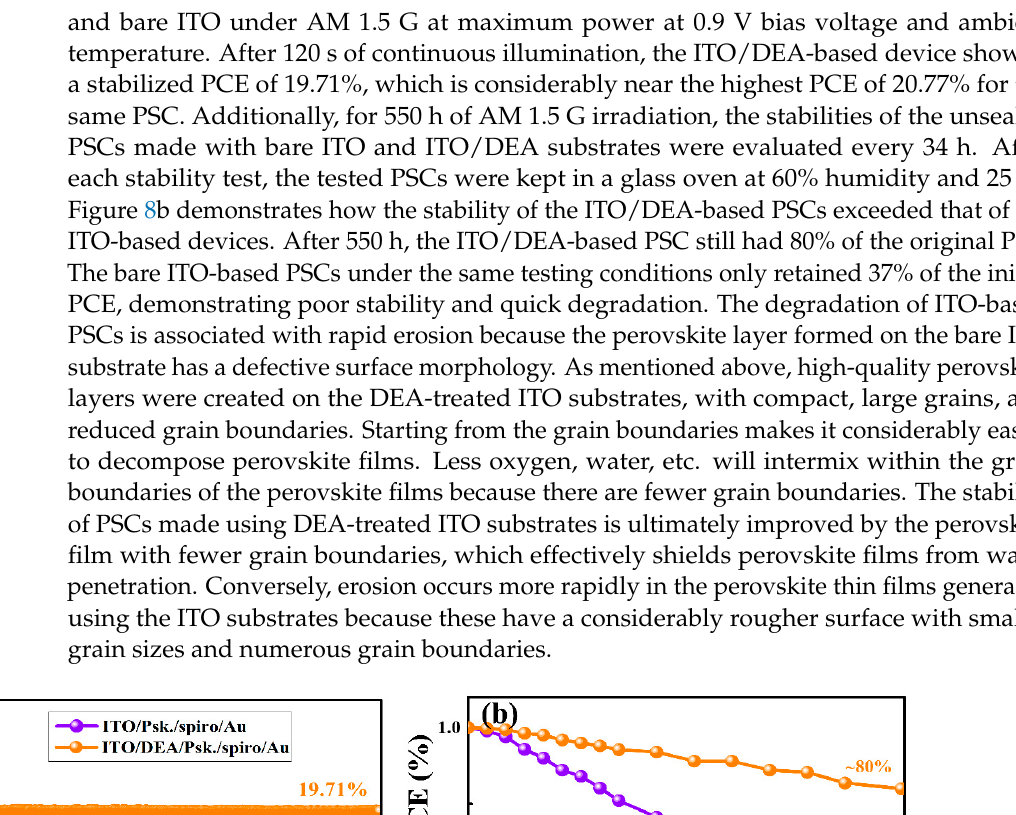
strates; Figure S2: KPFM images (a,b) and corresponding potential difference curves (c,d) of the bare